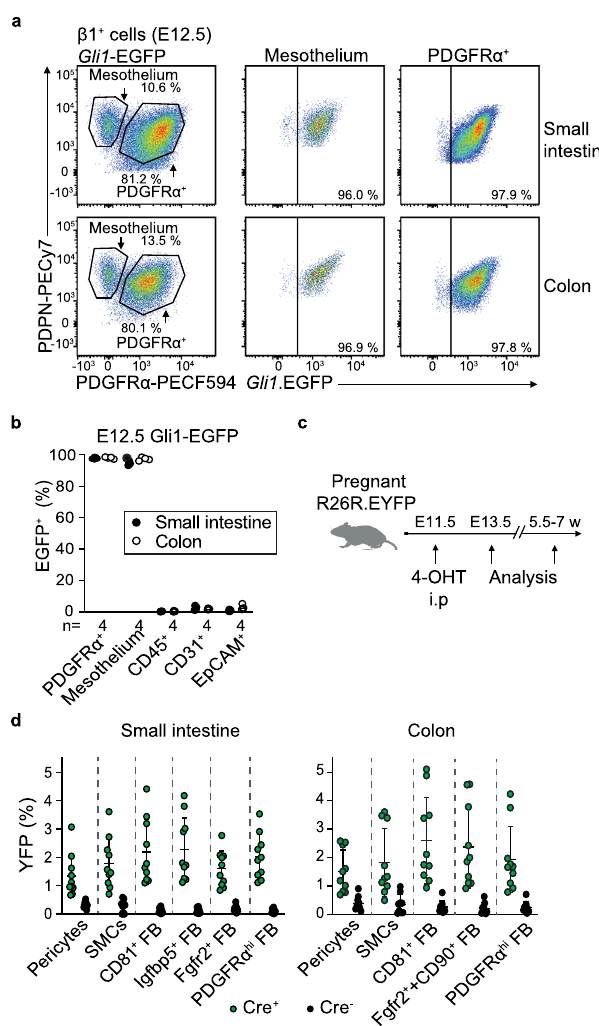
Fig. 4 | Adult intestinal MSC derive from Gli1 + embryonic precursors. a Representative fl ow cytometric analysis and b proportions of indicated cells expressing EGFP in the small intestine and colon of embryonic E12.5 Gli1 -EGFP mice. Results are from 8 individual embryos, with each circle representing an individual embryo. c Work fl ow of lineage-tracing experiments. R26R .EYFP females were mated overnight with Gli1 .CreERT2 +/ − males and pregnant dams injected i.p. with 4-hydroxytamoxifen (4-OHT) at E11.5. d Proportions of indi- catedMSCsubsetexpressing YFPinsmallintestineandcolonof5.5 – 7-week-old Gli1 .CreERT2 +/ − . R26R .EYFP (Cre + ) and R26R .EYFP (Cre − ) littermates. Results are pooled from 4 independent experiments with 10 Cre + mice and 11 Cre −